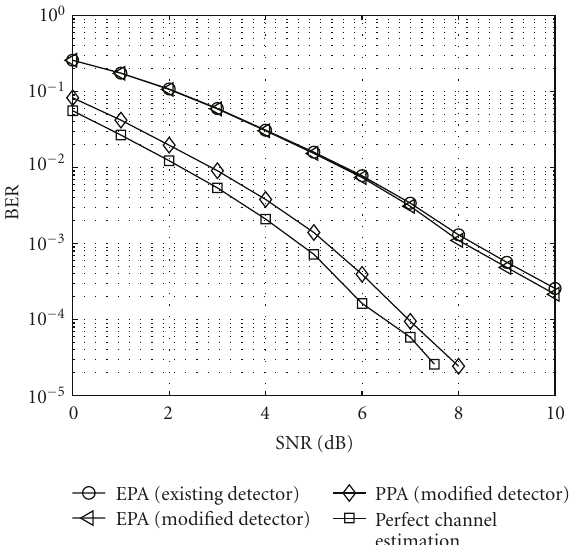
Figure 8: Normalized throughput of di ff erent power allocation schemes ( M R = 4, M T = 4).